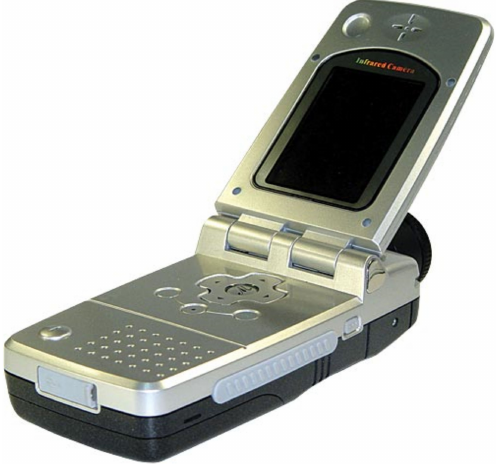
Figure 5. MobIR M4 portable infrared camera